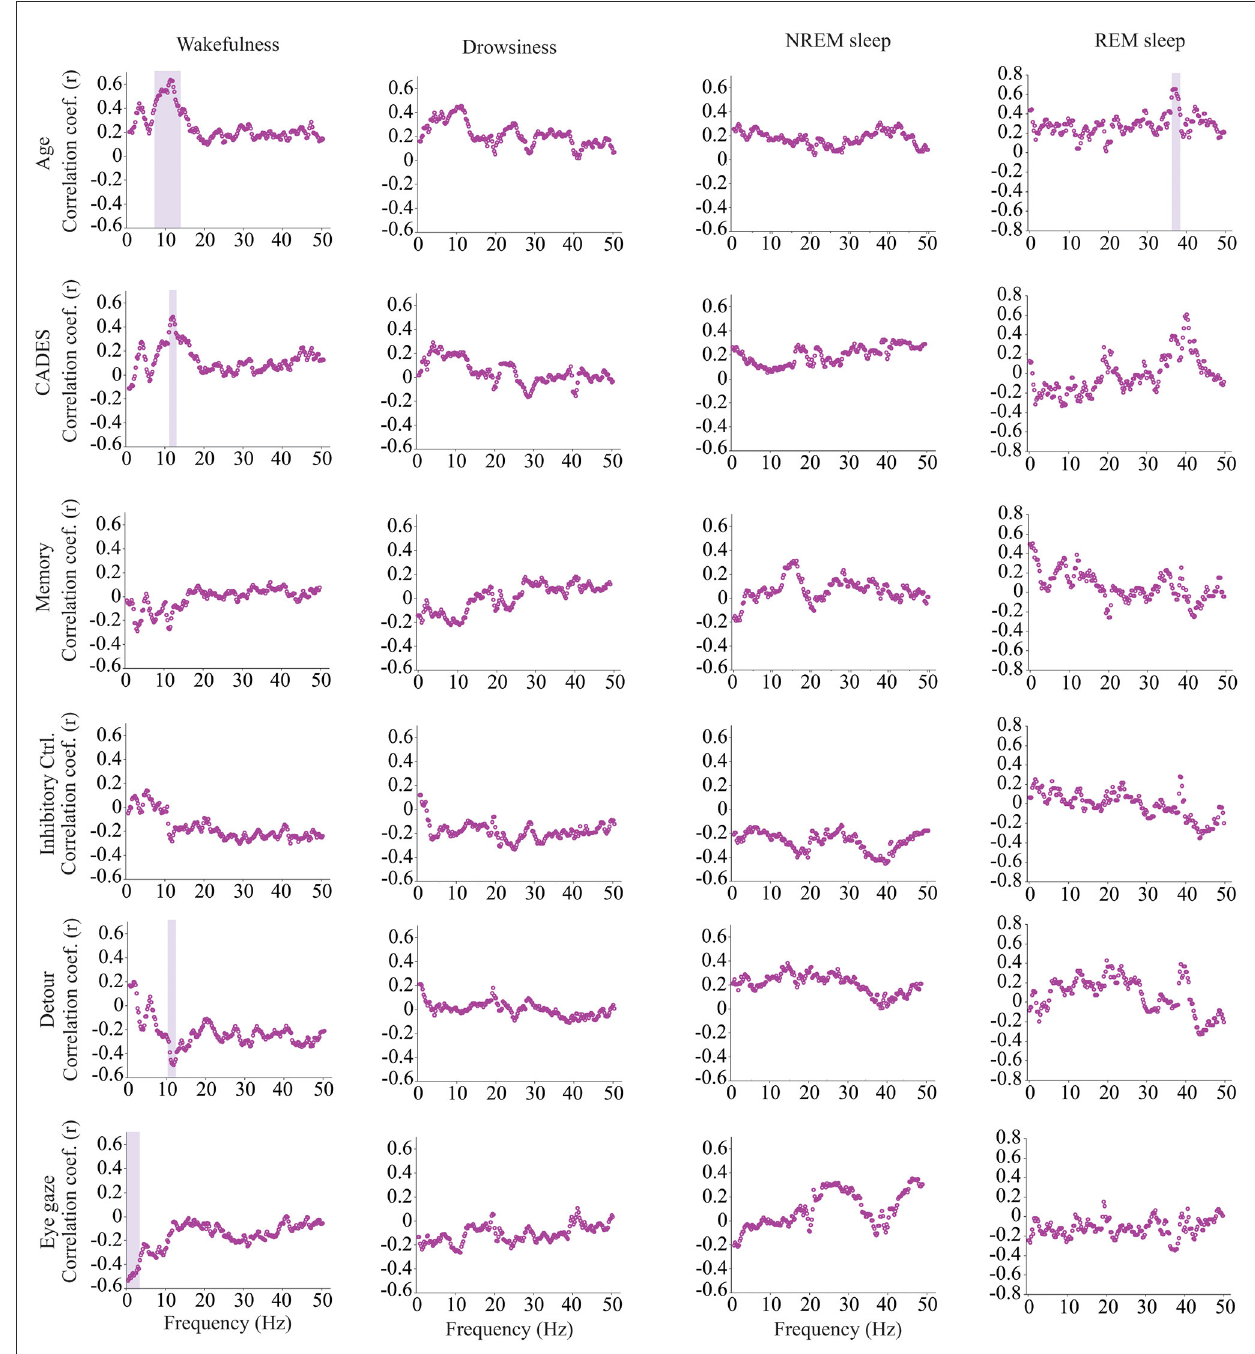
FIGURE5 Correlations between EEG interhemispheric (F3–F4) coherence and age, CADES score, or performance in cognitive tests. Spearman correlation coefficients are shown for each frequency bin. Frequencies with significant correlations are indicated with a purple shadow box. The analysis included only the dogs that entered each specific behavioral state (wakefulness n = 28, drowsiness n = 26, and NREM sleep n =